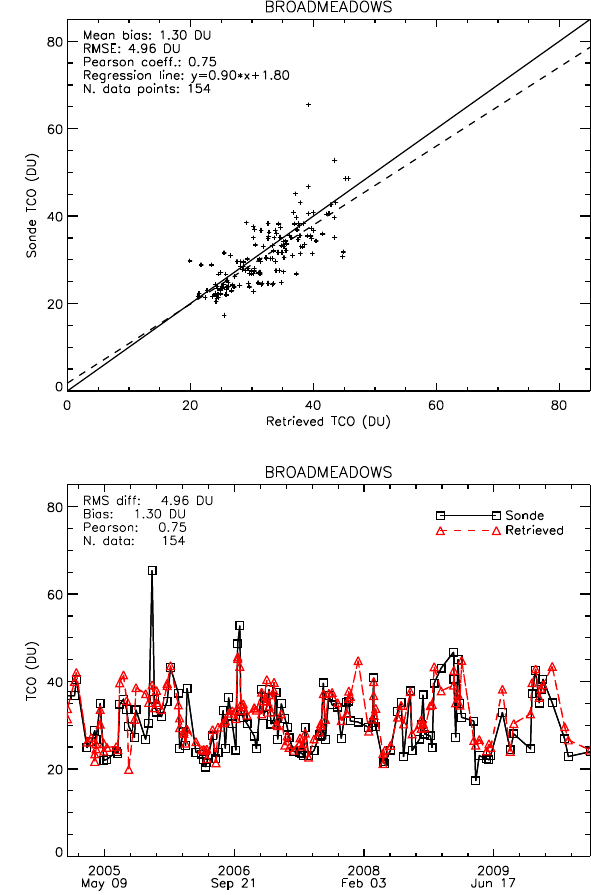
Fig. 5. Scatter plot (top) and time series (bottom) of retrieved and ozonesonde TCO at Broadmeadows